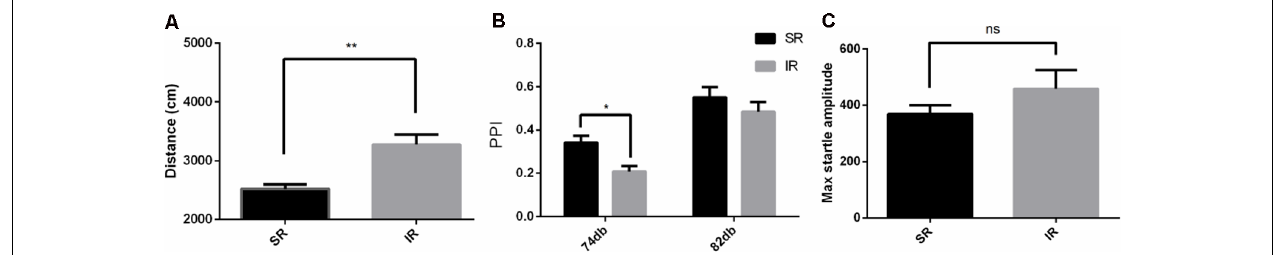
FIGURE 1 | Effects of isolation rearing on the behaviors of the wild-type mice, including the total distance traveled (A) in the open field test, the prepulse inhibition (PPI)% (B) in the acoustic startle response and the PPI test, and the pulse-alone amplitudes, (C) in the acoustic startle response and the PPI test. The results are expressed as the mean ± SEM [ n = 10 for the social-rearing (SR) group and n = 14 for the isolated-rearing (IR) group, * p < 0.05, ** p < 0.01, ns p > 0.05, student’s t -test and two-way ANOVA].